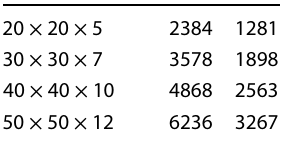
Table 2 List of mesh parameters (mesh setting on a boundary box, N v (number of vertices), and N t (number of triangles))